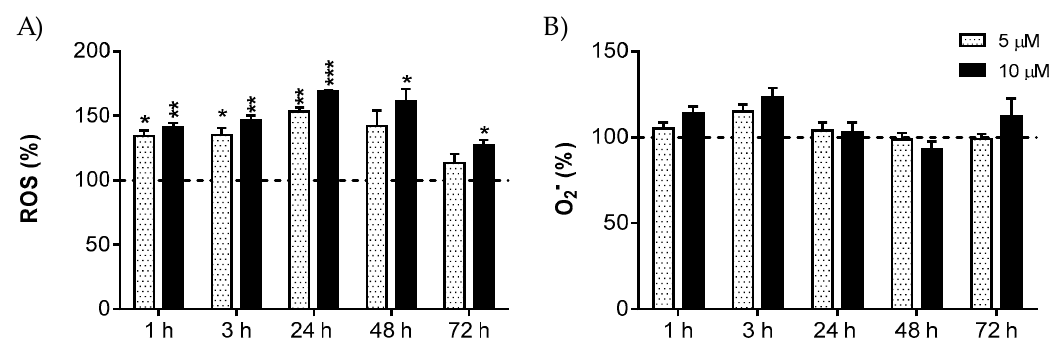
Figure 5. E ff ect of R2-viniferin on ( A ) intracellular ROS and ( B ) mitochondrial O 2 − levels in HepG2. Cells were treated with 5 and 10 µ M of R2-viniferin for the indicated times. Reactive species were detected by flow cytometry. ( A ) ROS were determined by H 2 DCF-DA assay. ( B ) O 2 − was determined by MitoSOX probe. Results are expressed as the percentage (%) of the control values at the same time, and are the mean ± SE of 3 experiments. * p < 0.05; ** p < 0.01; *** p < 0.001.